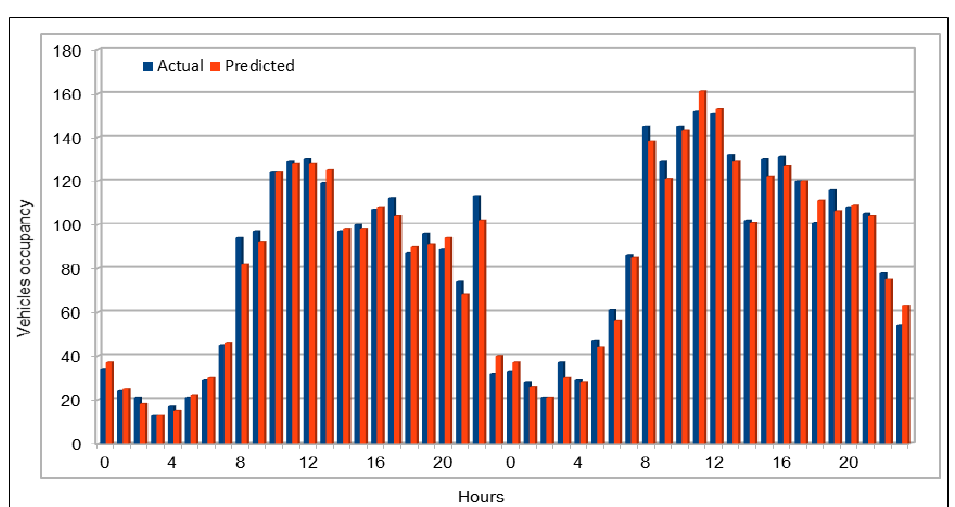
Figure 14. Traffic occupancy: Actual and predicted values (all 26 VDS) (peak hour).